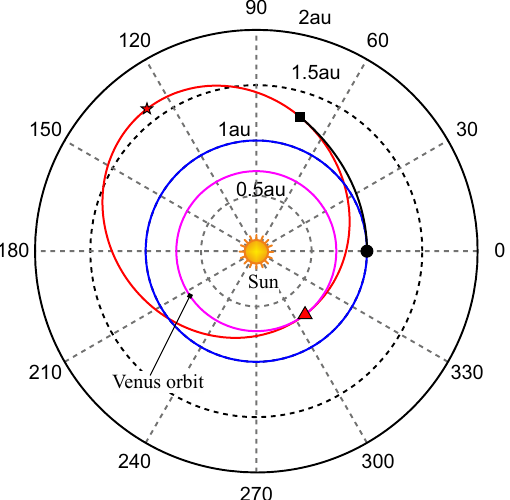
Figure 13. Optimal transfer performances in a Venus-based mission scenario ( e f = 0.3831) as a function of β .